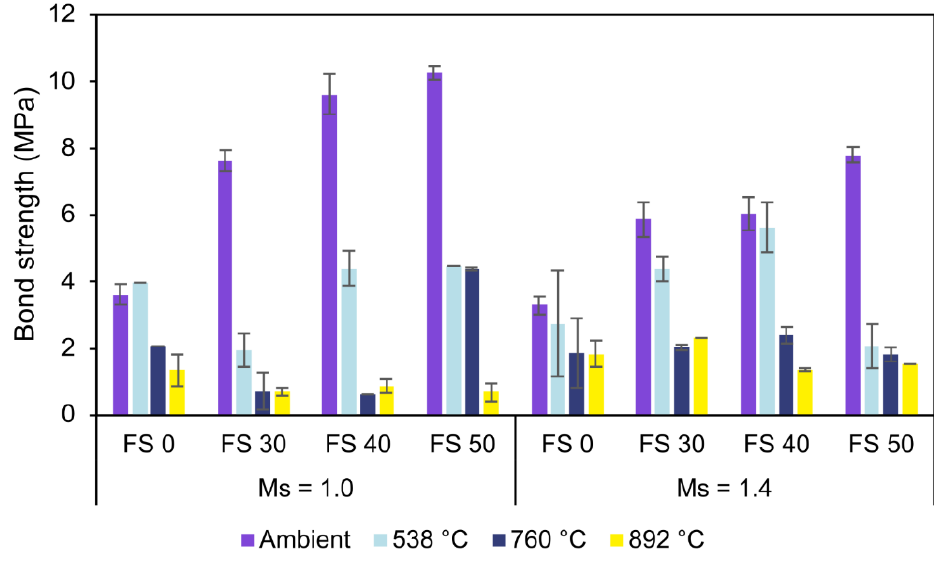
Figure 25. Bond behavior of AAC.